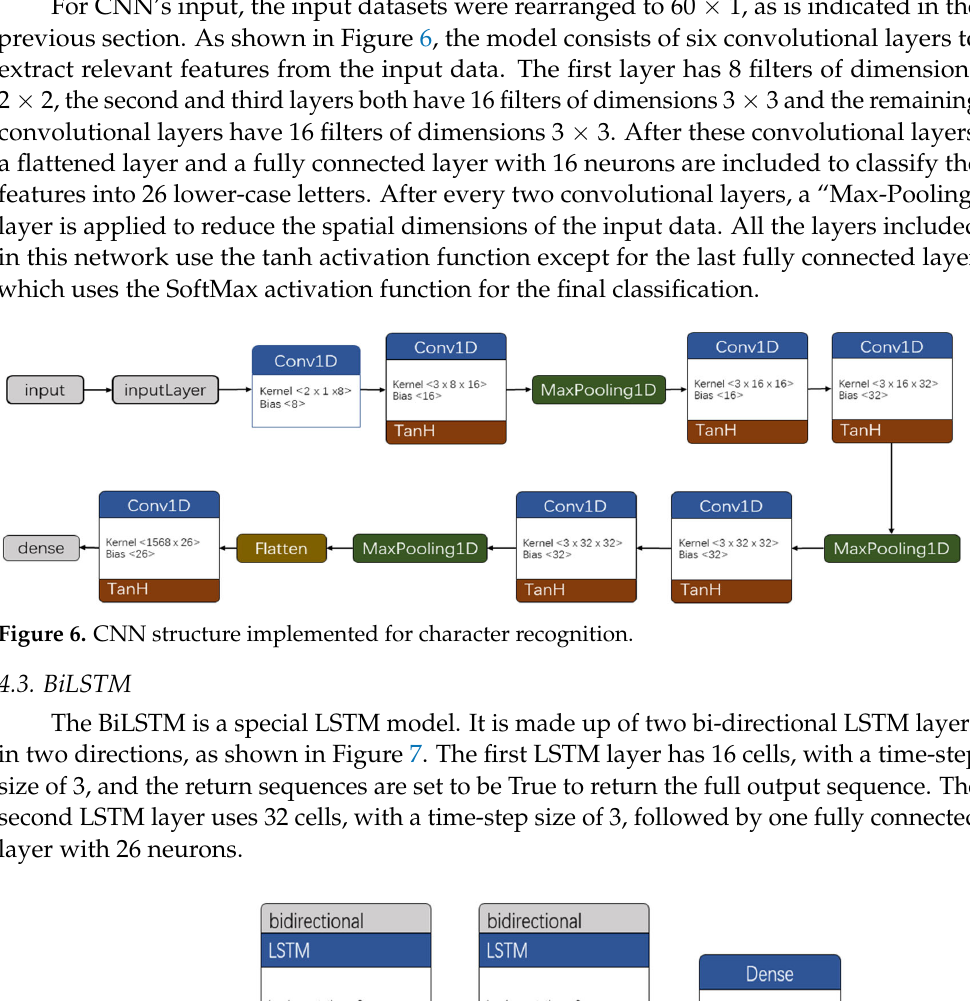
Figure 5. LSTM structure implemented for character recognition.